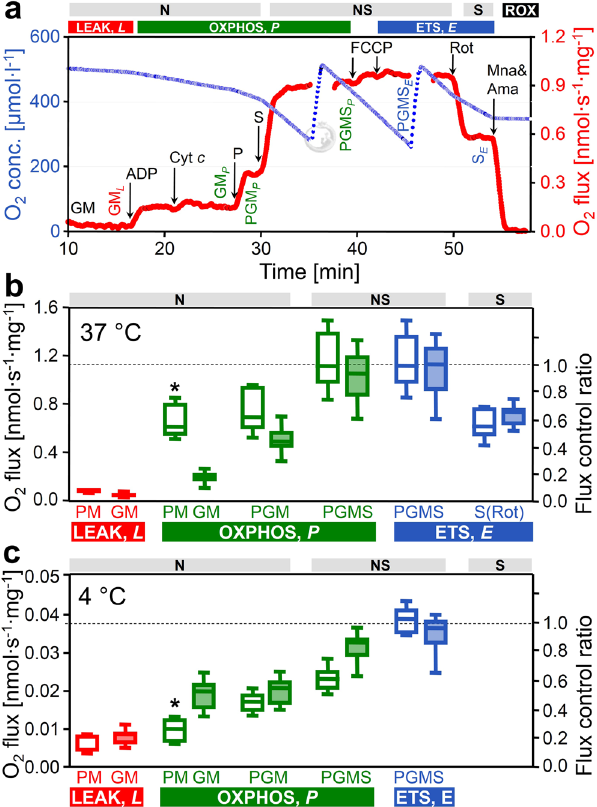
Figure 2. Respiration of permeabilized cardiac fibers ( J O2 , per wet weight), and flux control ratios normalized for NS-ETS capacity. ( a ) Oxygen consumption measured at 37 °C in SUIT 2 protocol: GM (N-LEAK respiration; GM L ), ADP (N-OXPHOS capacity; GM P ), cytochrome c (integrity of outer mt-membrane), pyruvate (N-OXPHOS capacity;